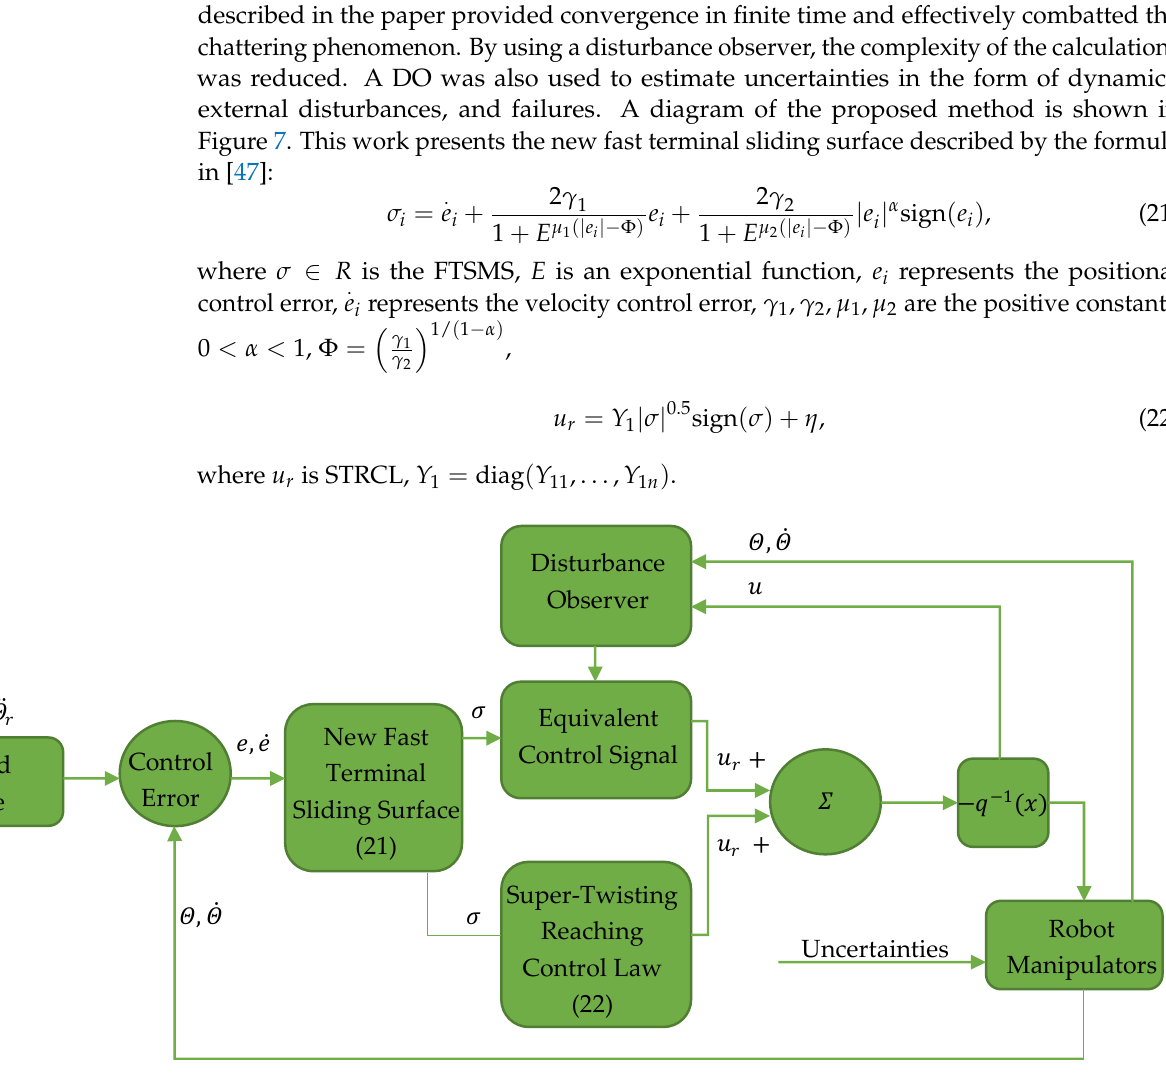
Figure 7. Diagram FTSMS-STRCL-DO [47].